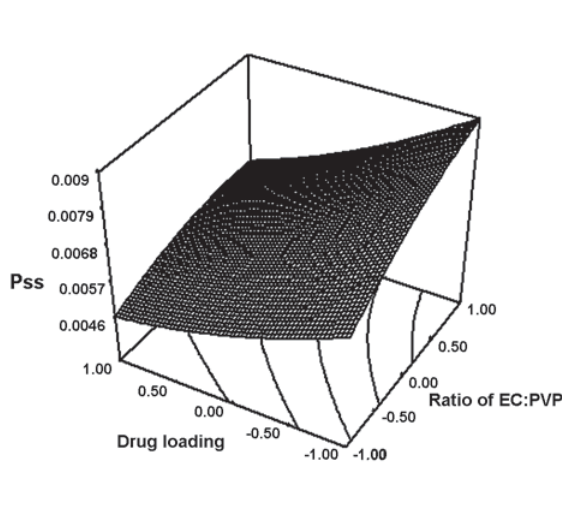
Figure 8 – Contour plot for permeability coefficient (P ing the effect of the ratio of EC: PVP and drug loading on P Table 5 – Primary skin irritation study results. Animal N.